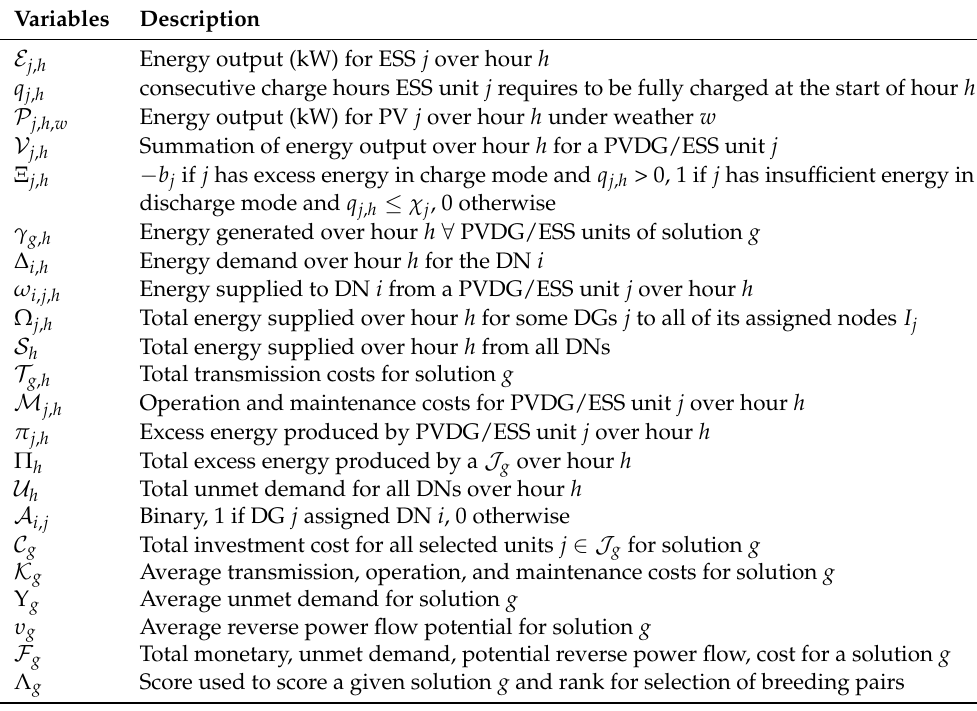
Table 3. Variables used for the MG model and